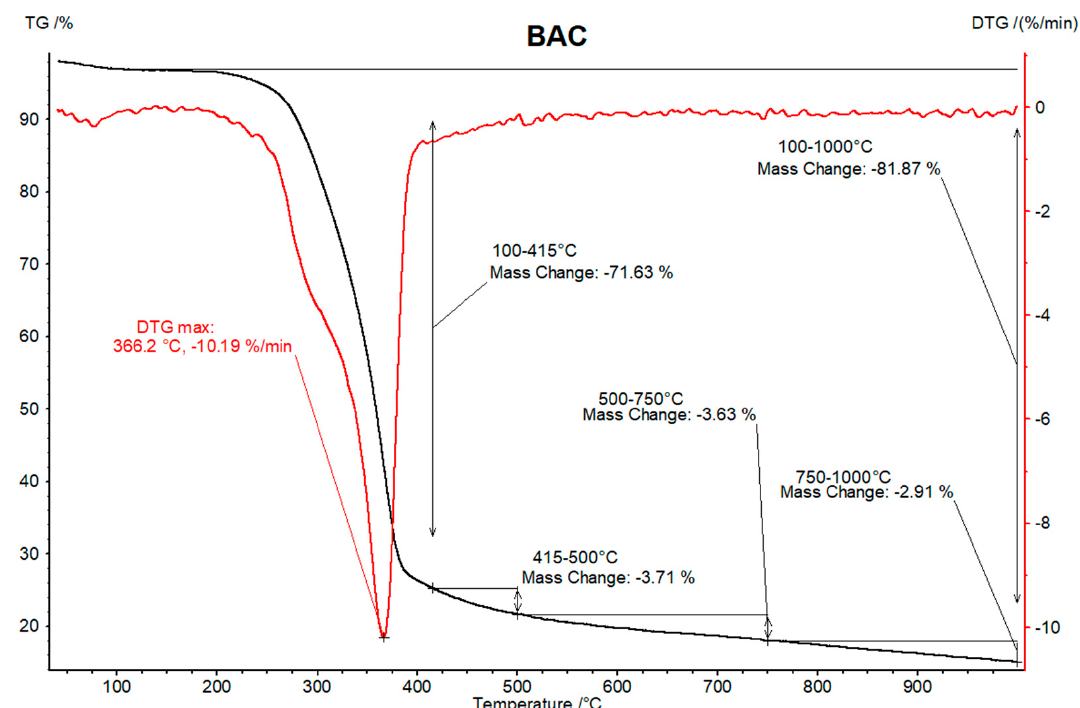
Figure A3. TG/DTG curves obtained for beech/alder chips.